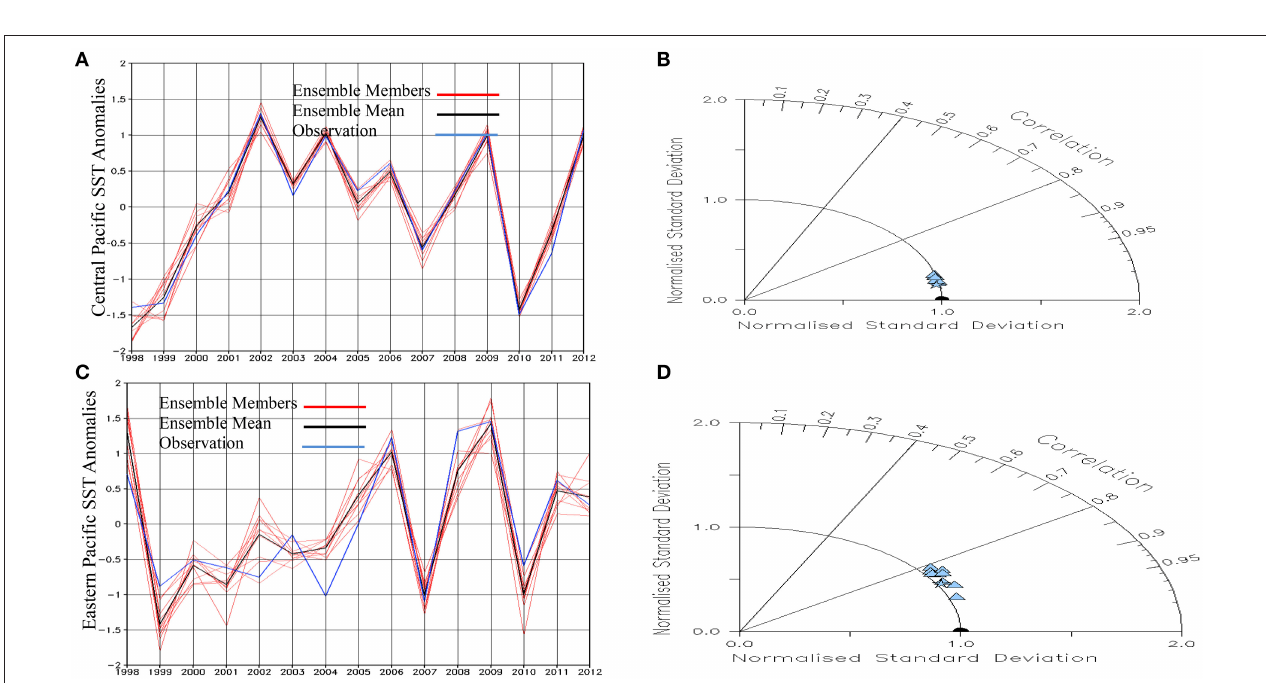
FIGURE 2 | Inter-annual variability of standardized SST anomaly over (A) the Central and (C) Eastern Pacific by the ensemble members (red-lines), the ensemble mean(black-line) and observed Era-Interim (blue-line); (B,D) Taylor diagrams showing the normalized standard deviations and the correlation coefficients of S2S ensemble simulations with observation for panels a and c respectively (ensemble members—blue triangle; blue circle for negative correlations), ensemble mean—blue star and Era-Interim (observation)—black semi-circle. The normalized standard deviations and correlations are with reference to Era-Interim over same area.